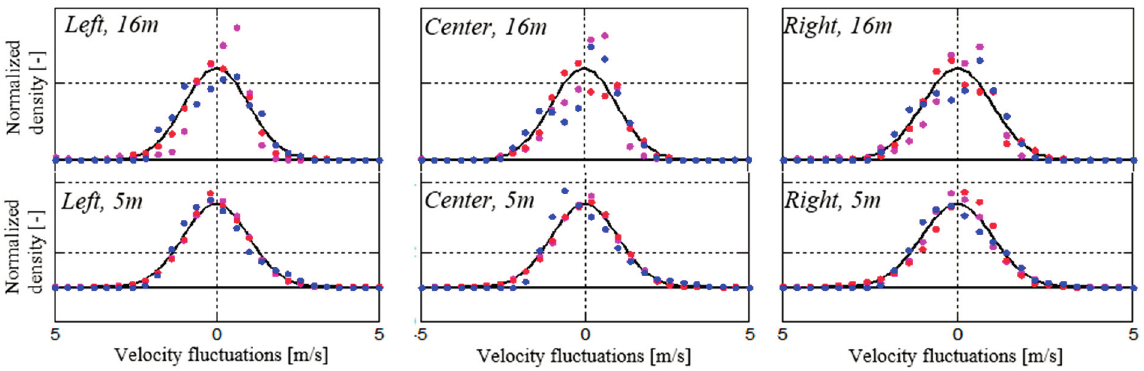
Figure 6. Normalized distribution of u ( blue ), v ( red ) and w ( purple ) fluctuating components .